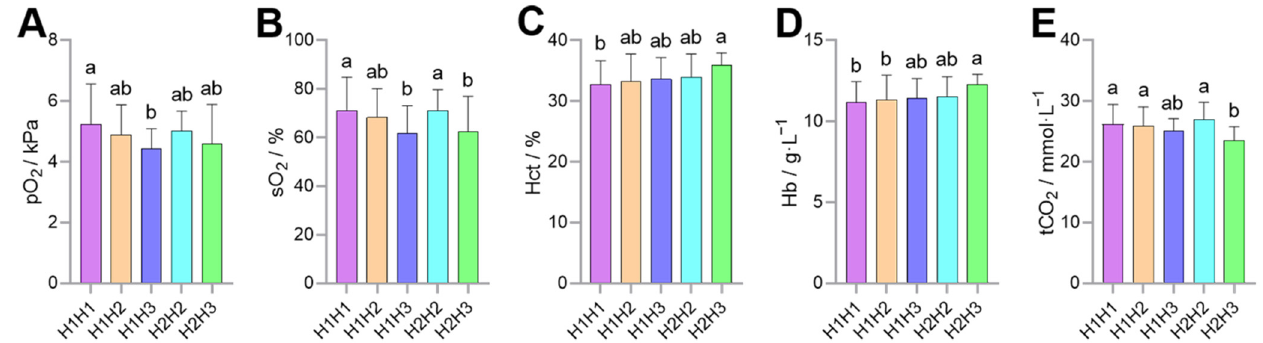
Figure 6. Association analysis of haplotype combinations with partial pressure of oxygen (pO 2 ) ( A ), oxygen saturation (sO 2 ) ( B ), hematocrit (Hct) ( C ), hemoglobin (Hb) concentration ( D ) and total carbon dioxide (tCO 2 ) ( E ). Different lowercase letters (a,b) indicate significant differences ( p < 0.05).